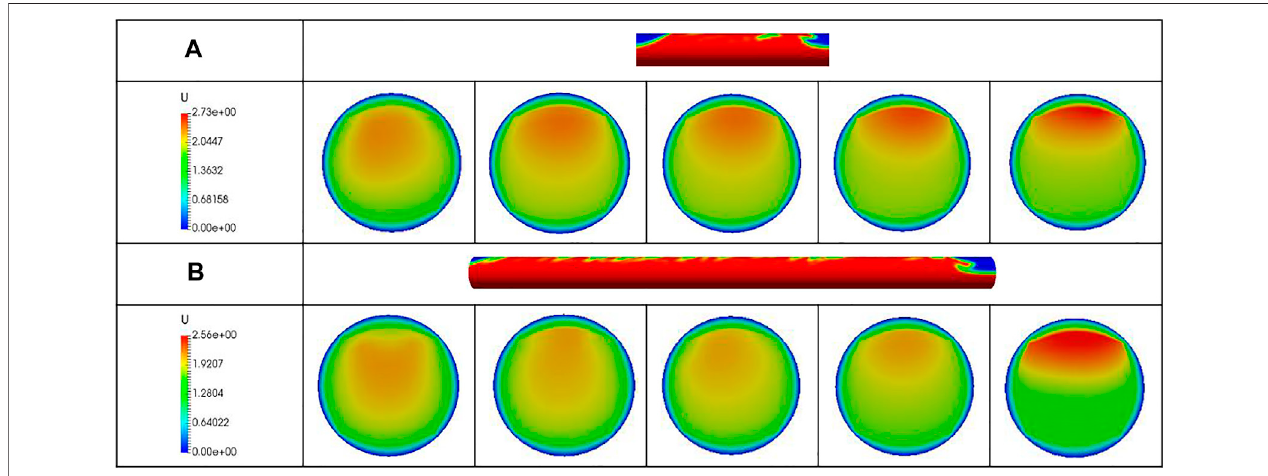
FIGURE 18 | Cross-sectional fl ow distributions in (A) a developing and (B) a fully-developed slug ( V sg (cid:2) 2 m/s, V sl (cid:2) 1 m/s).